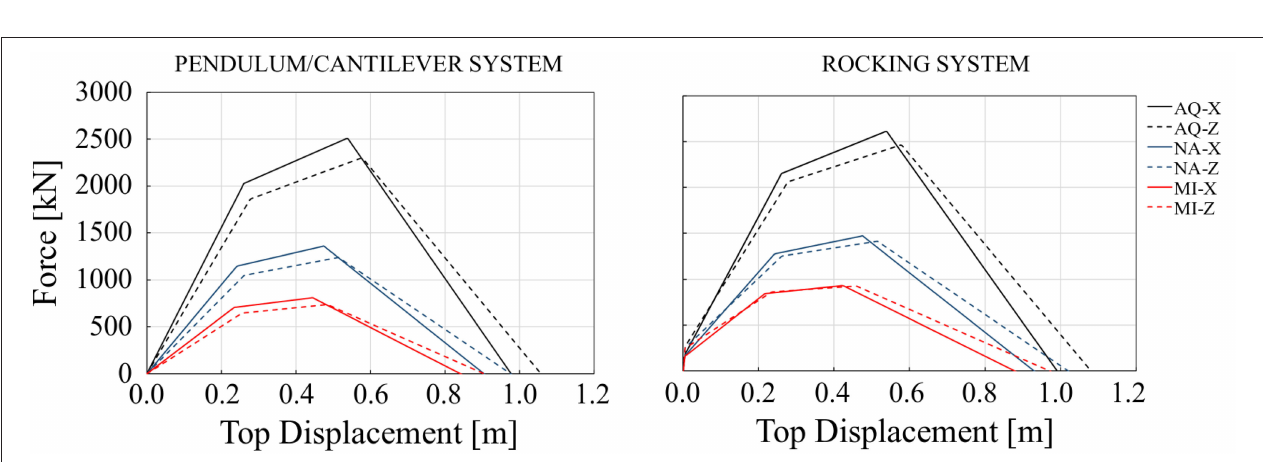
FIGURE 6 | Pushover analysis results for Pendulum and Cantilever panel arrangement.